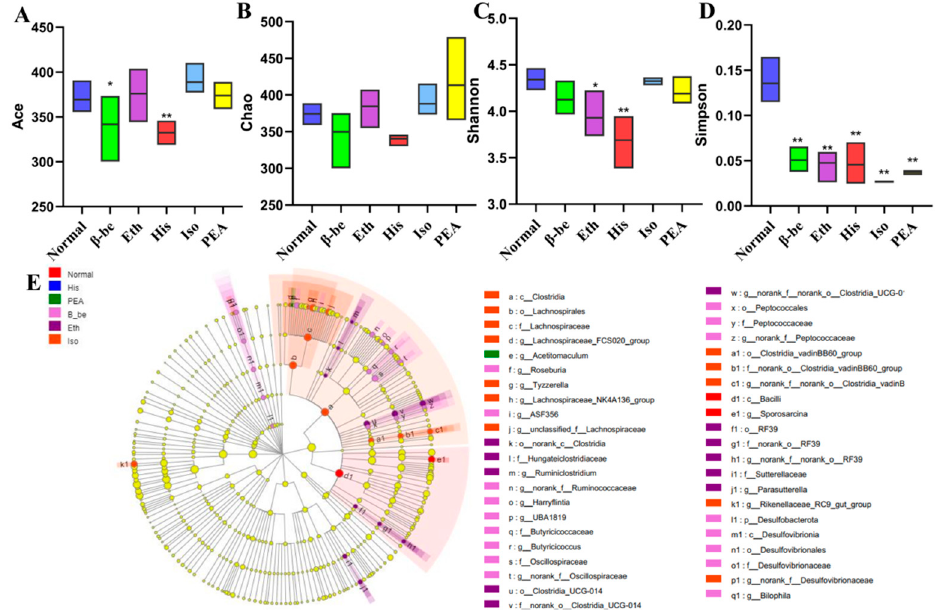
Figure 4 . The effects of His, PEA, β -be, and Iso on the Alpha diversity of gut microbiome in mice. * p < 0.05; ** p < 0.01. ( A ) Ace index. ( B ) Shannon index. ( C ) Chao index. ( D ) Simpson index. ( E ) Biological cladograms.